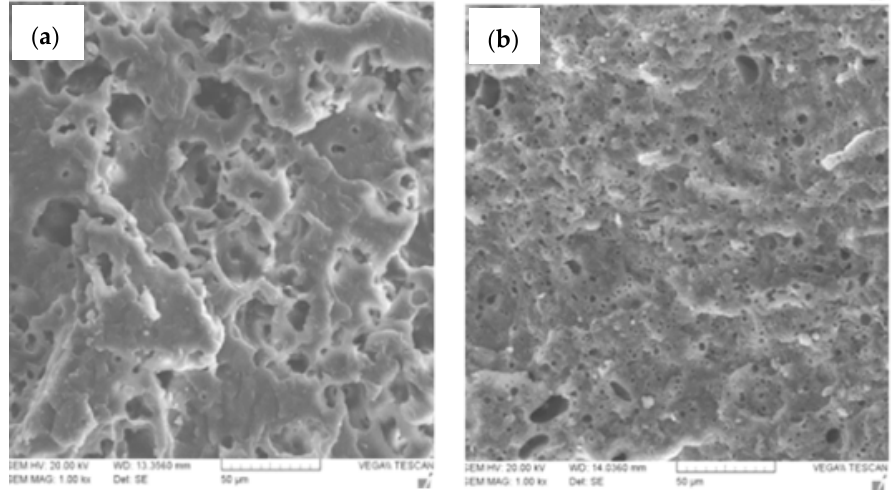
Figure 7. SEM micrographs of PLA/TPS blends (70/30 w / w ) ( a ) without and ( b ) with 2 phr PLA- g - MA (adapted from Moghaddam et al. [39], copyright Springer Science, reproduced with per- mission ).